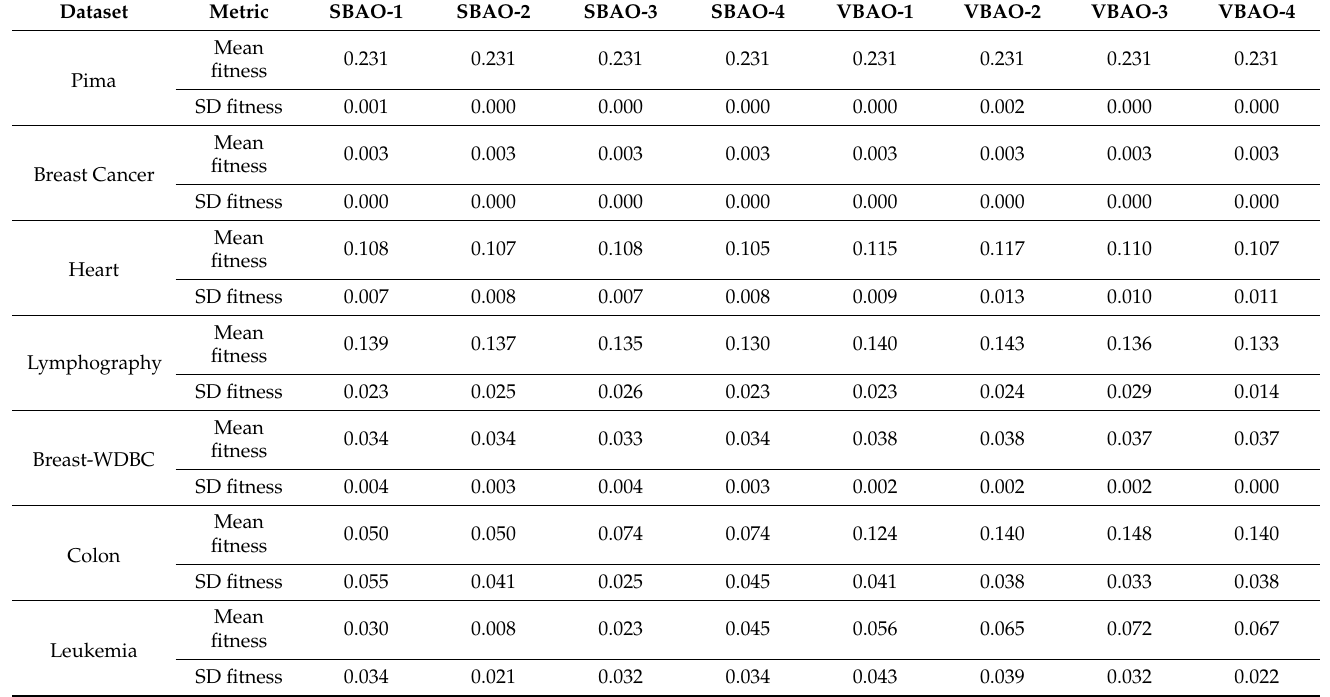
Table 6. The fitness comparison of SBAO and